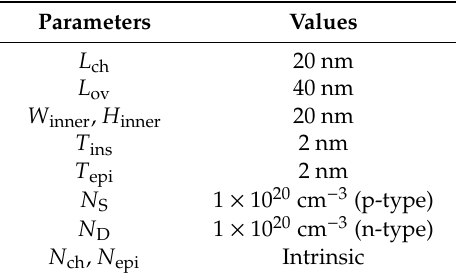
Table 1. Device parameters for